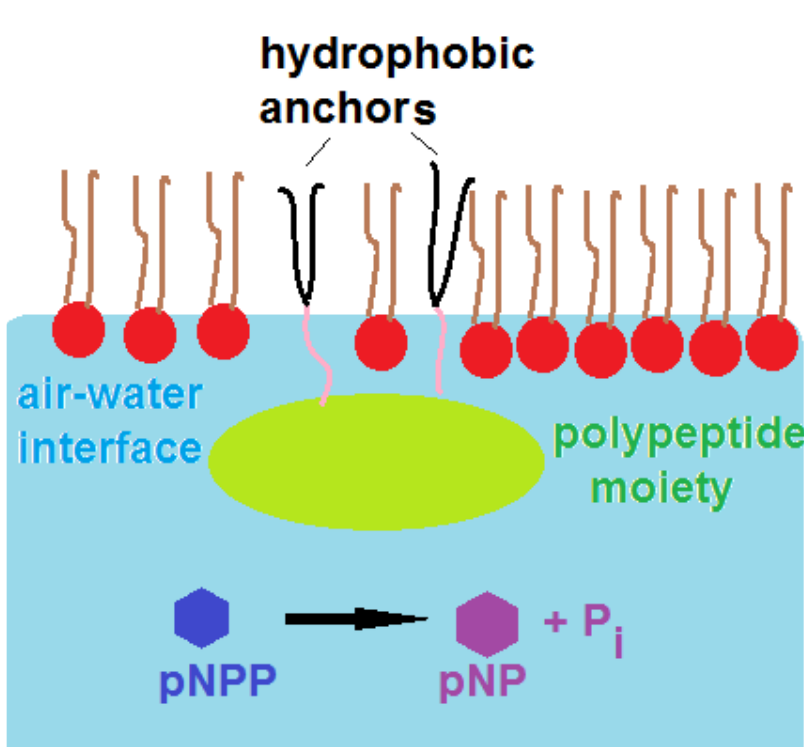
Figure 3 - Scheme for the experiment shown in (Caseli et al. 2005b) where a GPI- anchored enzyme (alkaline phosphatase) forms a lipid-enzyme Langmuir monolayer mimicking the out layer of a plasmatic membrane. pNPP (p-nitrophenhophosphate)